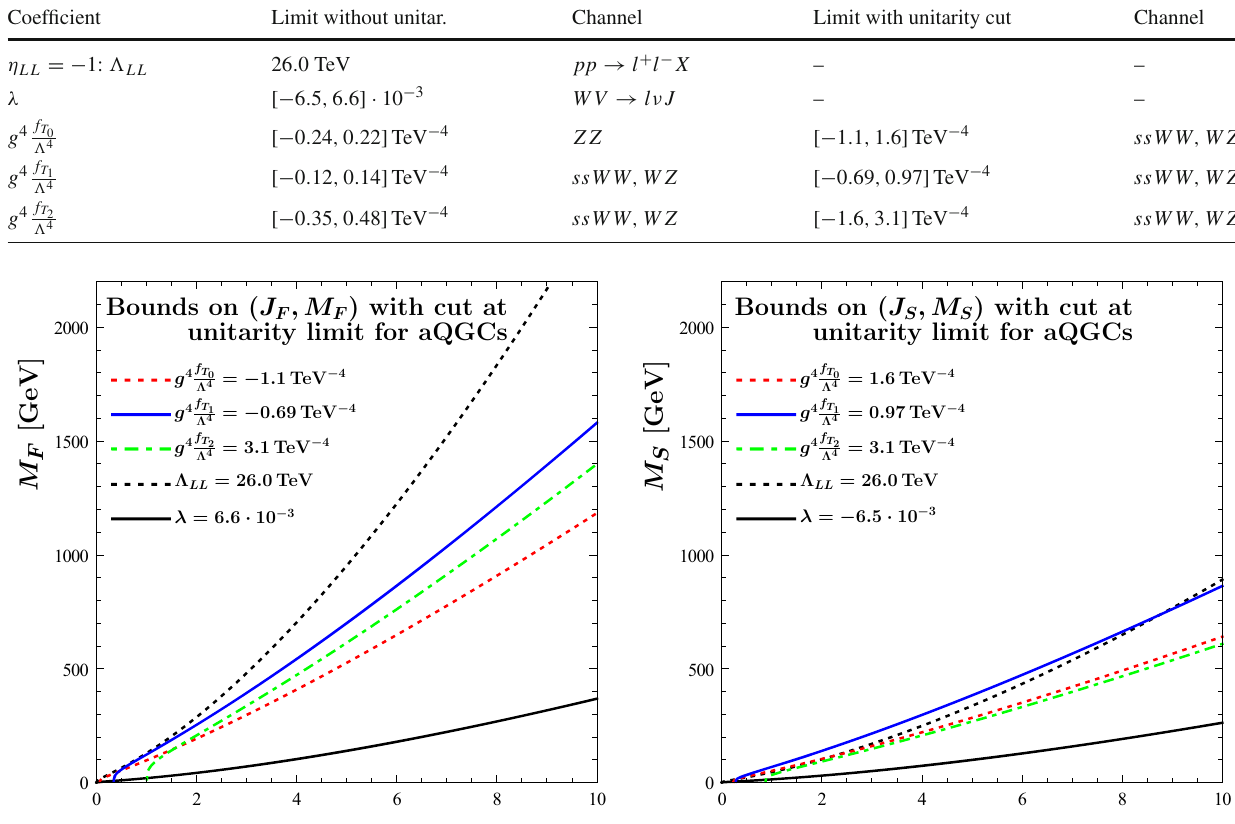
form of a cut at the perturbative unitarity limit of the EFT calculation. In addition, we name the channels from which the presented bounds are derived